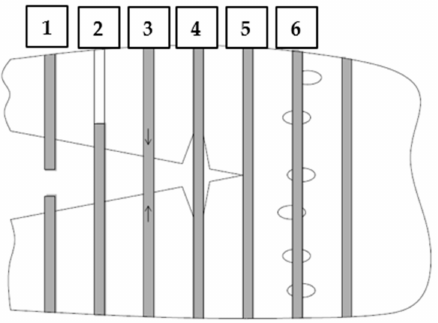
Figure 14. Failure mechanisms of FRC: 1—fiber rapture; 2—fiber pull-out; 3—fiber bridging